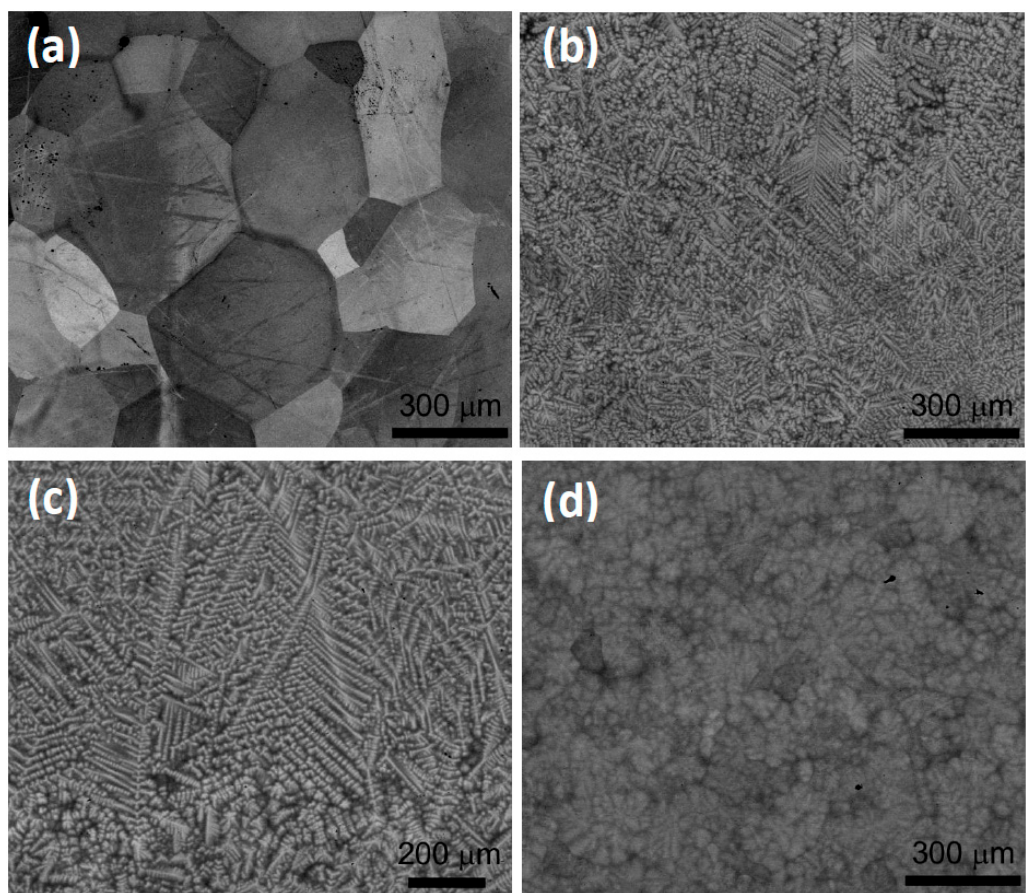
Figure 7. Back-scatter electron SEM micrographs of the alloys studied: ( a ) NbTaTi, ( b ) NbTaTiZr, ( c ) Nb 0.5 TaTiZr 1.5 , and ( d ) HfNbTaTiZr.